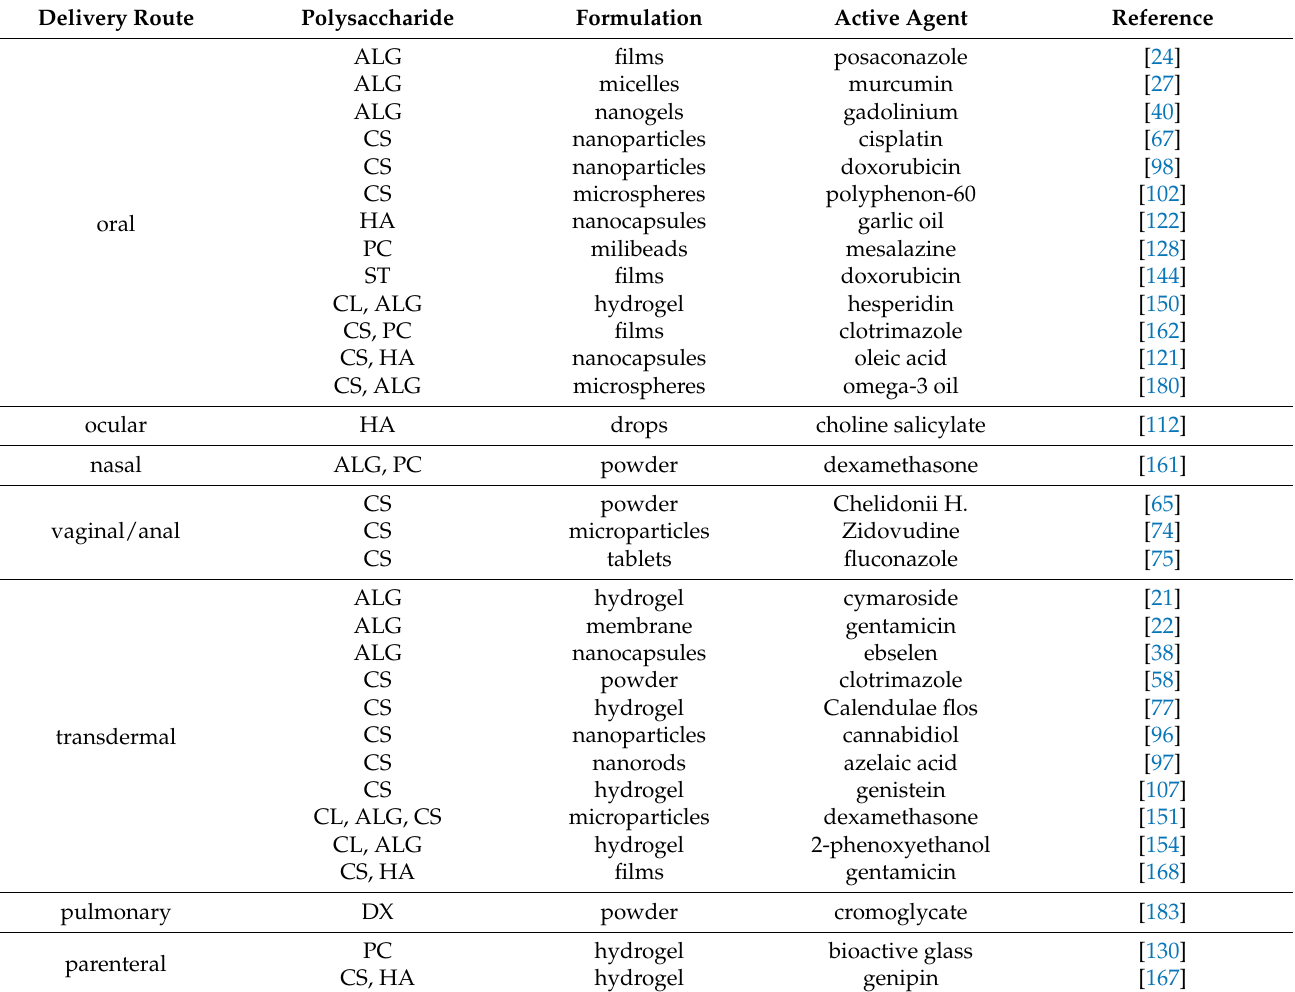
Table 2. Delivery routes of the selected polysaccharide-based